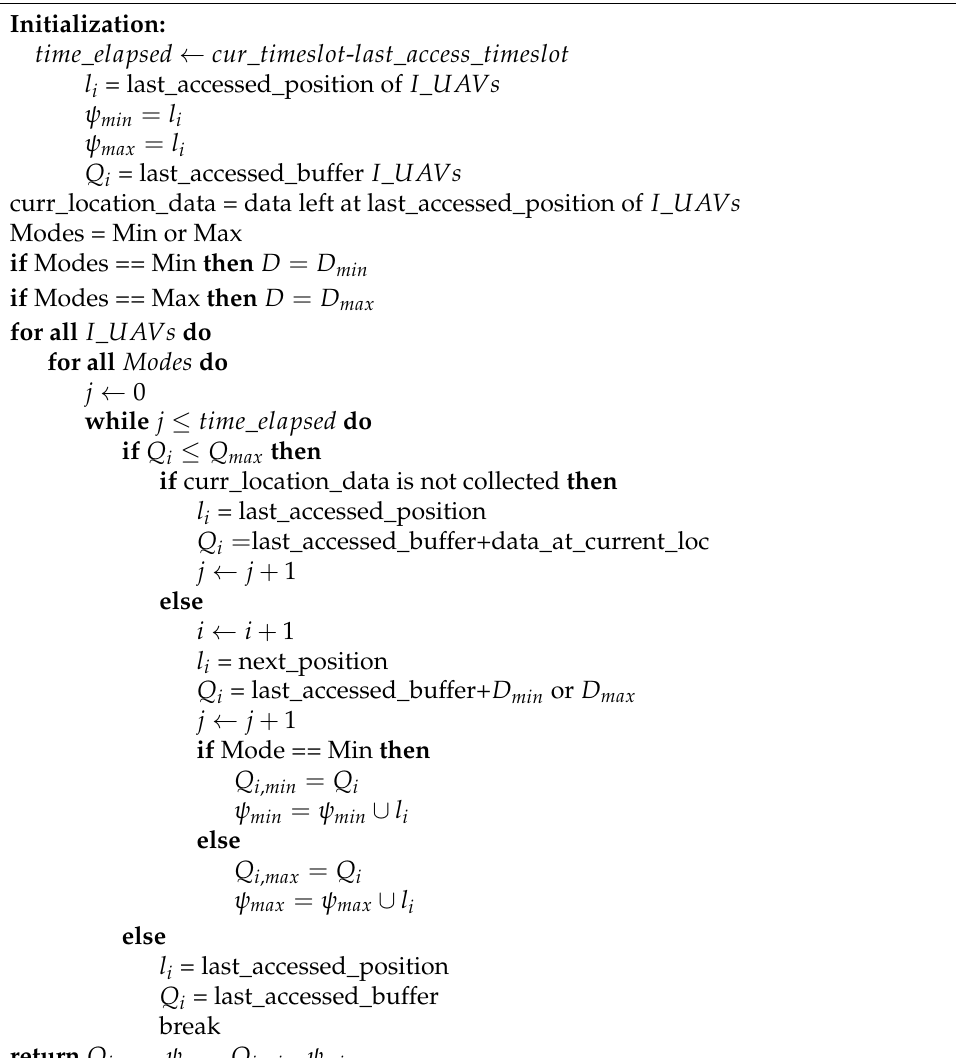
Figure 2. Division of a timeslot with different functions of A _ UAV . Algorithm 1 Estimated position and queue length of I _